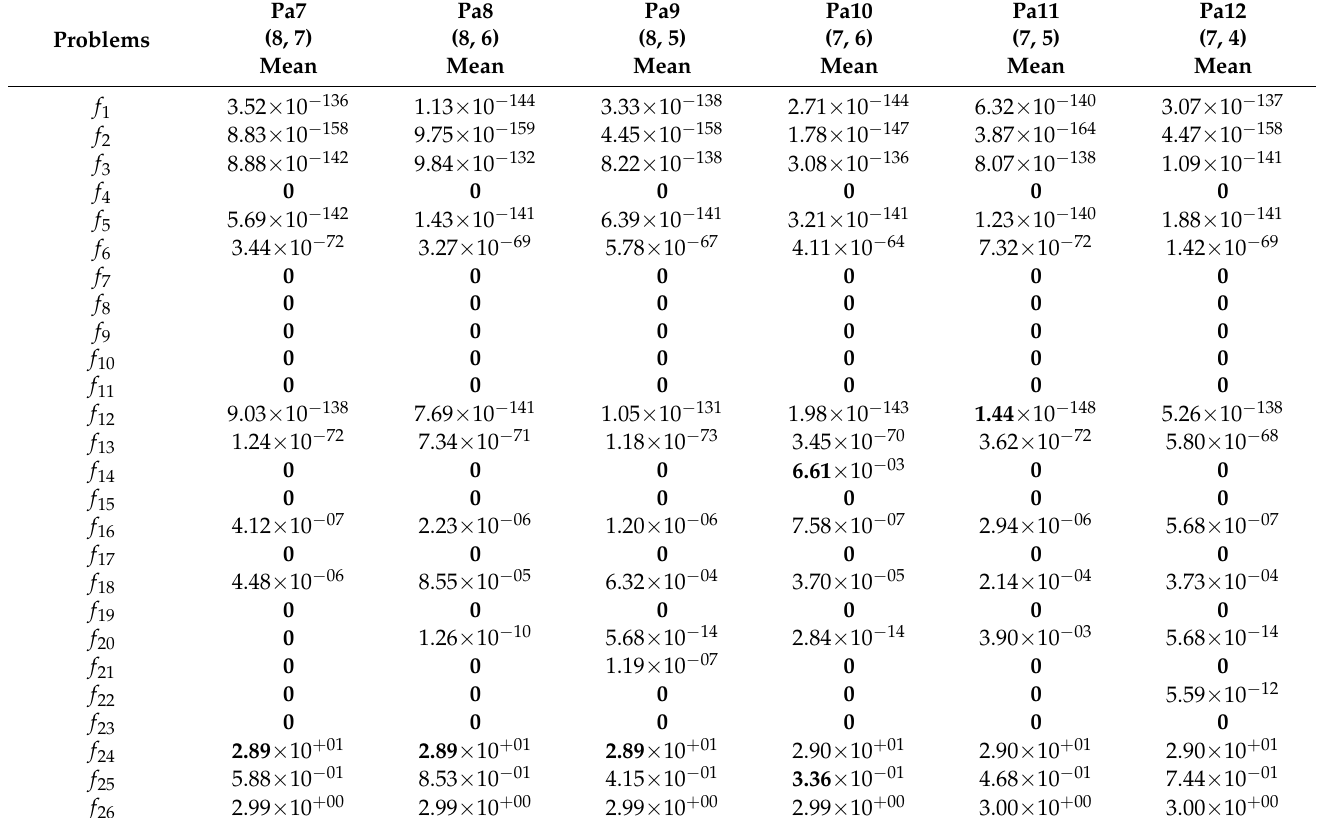
Figure 8. Search curves of DPTCFA with different parameters f 5 and f 20 ( D = 30). Table 3. Results of the parameter analysis of DPTCFA ( N 0 = 8 and N 0 =